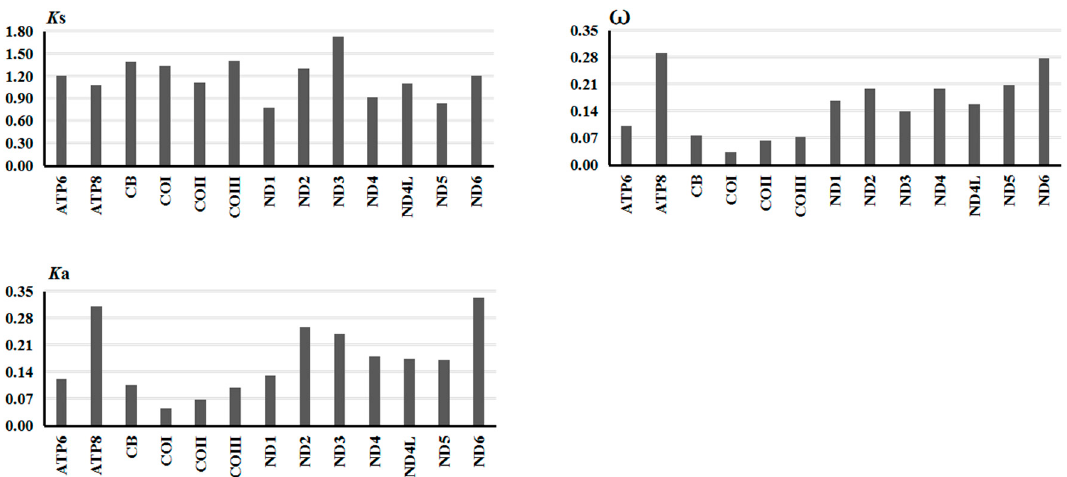
Figure 3. Evolutionary rates of 13 protein-coding genes in the ten Tenebrionidae mitogenomes. K s denotes Synonymous nucleotide substitutions per synonymous site; K a denotes nonsynonymous nucleotide substitutions per nonsynonymous site; ω denote the ratio of K a/ K s.